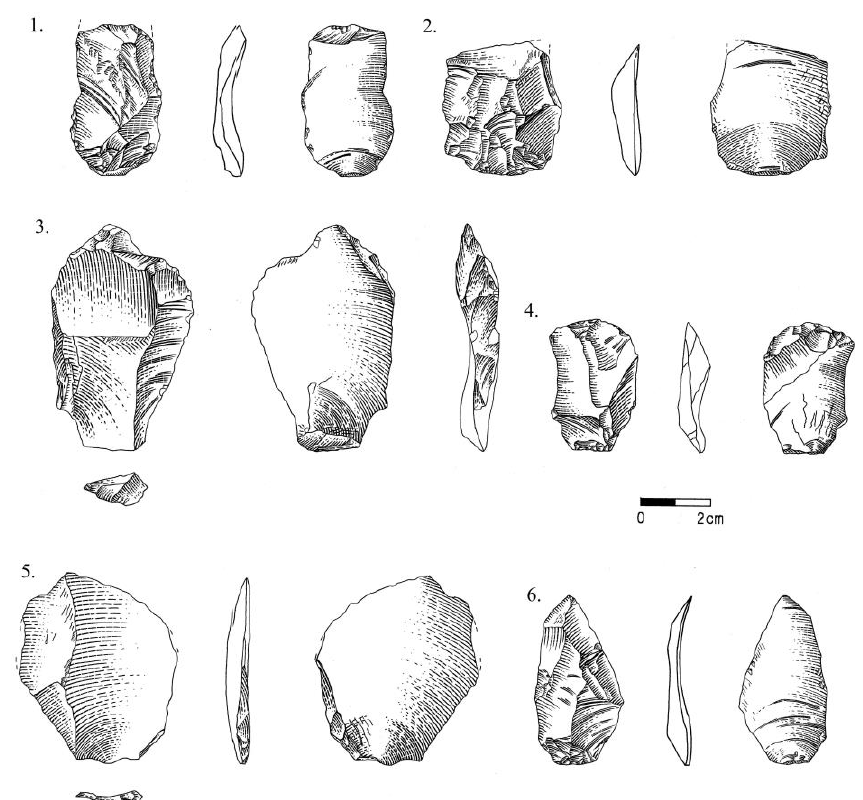
Figure 1. Examples of artifacts from the archaeological assemblage. All artifacts are é clat de taille de biface except for no. 3 which is a flake. 1. #7635 Layer V-5; 2. #7633 Layer V-6; 3. #7667 Layer V-6; 4. #7677 Layer V-6; 5. #7657 Layer V-5; 6. #5485 Layer